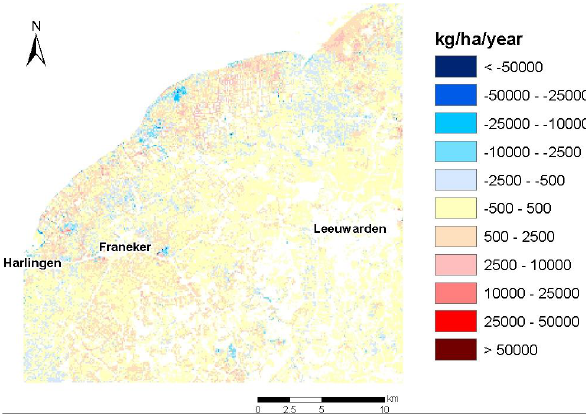
Fig. 20. Change in salt load between the autonomic scenario (year